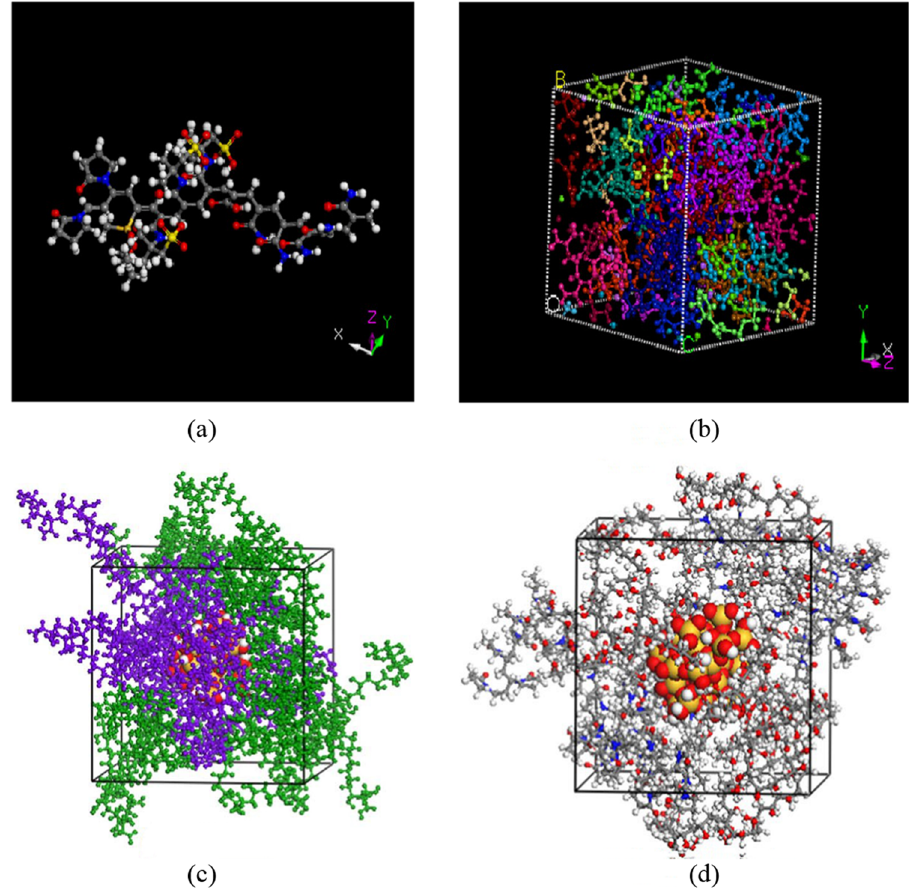
Figure 11: ( a ) 3D - structure of silica - polyacrylate composite [ 58 ] , ( b ) cellular structure of silica - polyacrylate composite [ 58 ] , ( c ) 6PVA/6PAM/ 1 silica ( 6.9 wt% SiO 2 content ) [ 223 ] , and ( d ) 4PVA/4PVP/1 silica ( 10% SiO 2 ) [ 223 ]